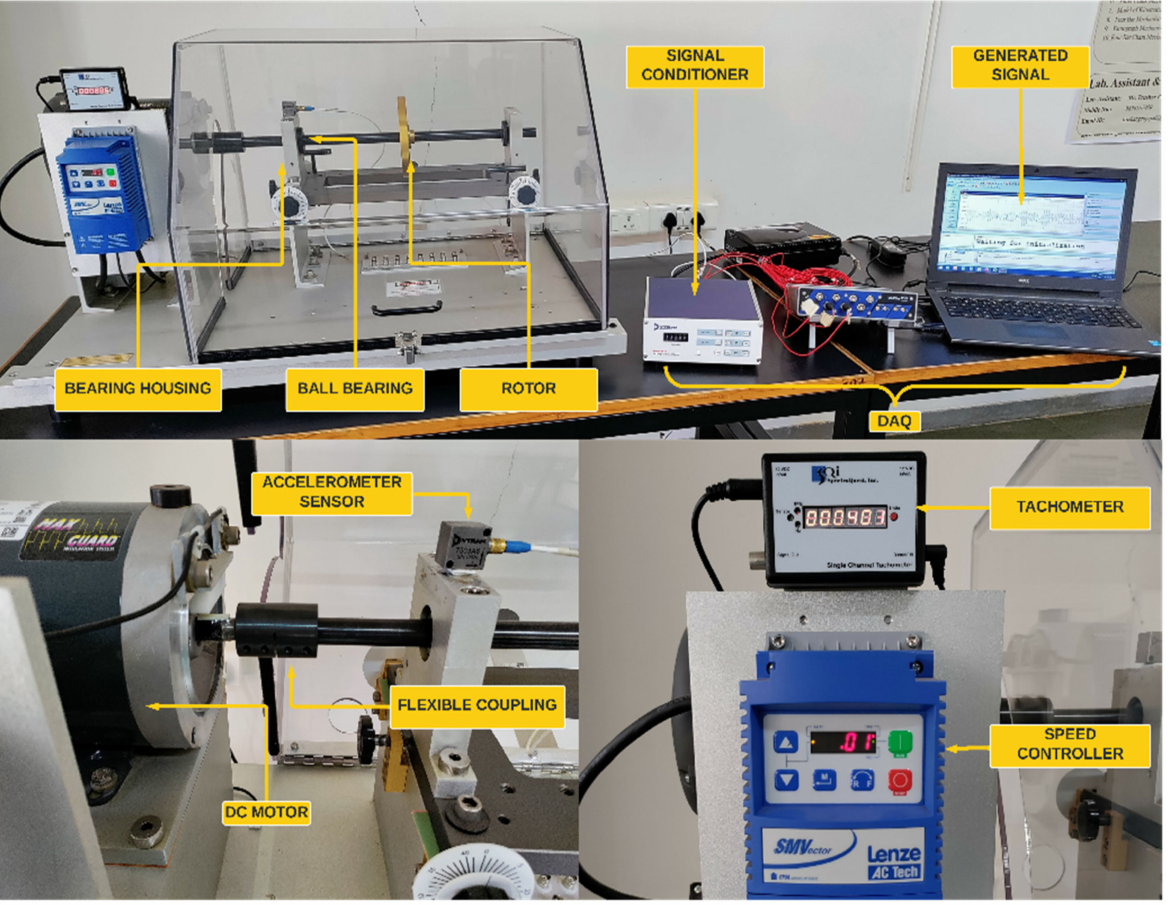
Figure 7. Machinery Fault Simulator